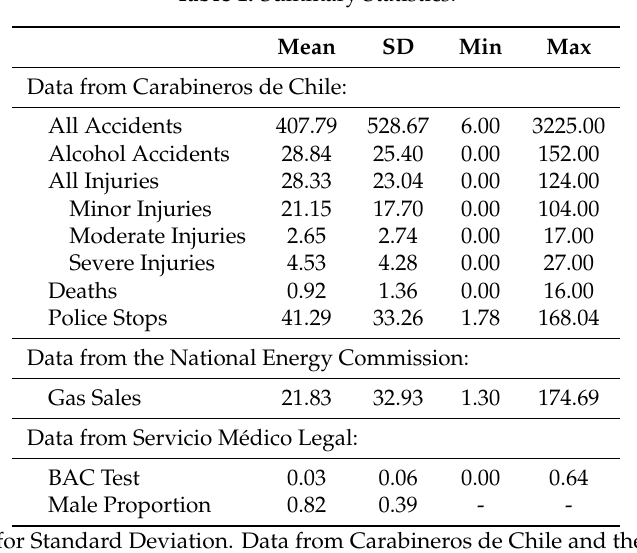
Table 1. Summary